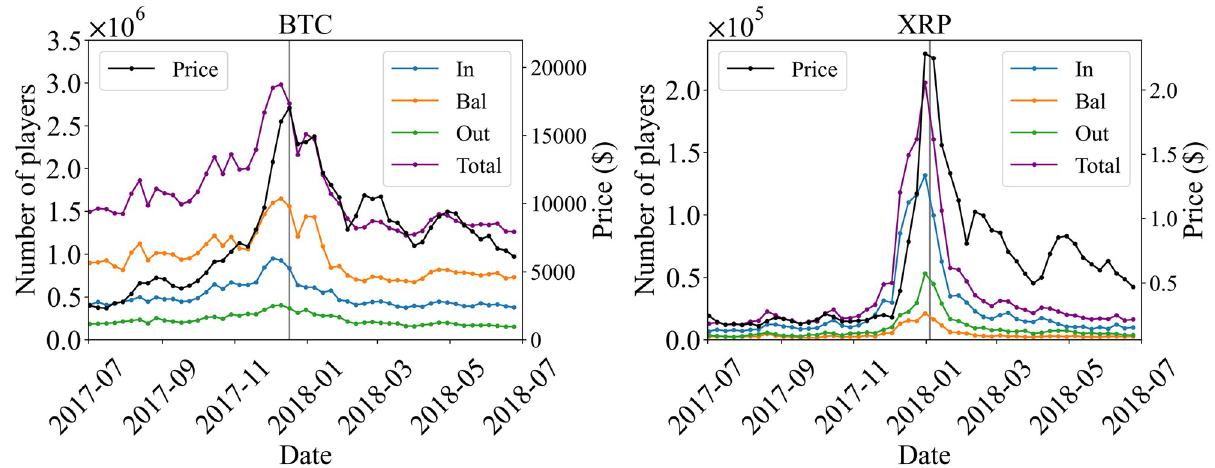
Fig 3. Time series of the number of In-, Bal-, and Out-players (weekly total), | P ( The black line represents the one-week-average price. The week that contains the day of the peak, t = 25 is represented by the gray vertical line.